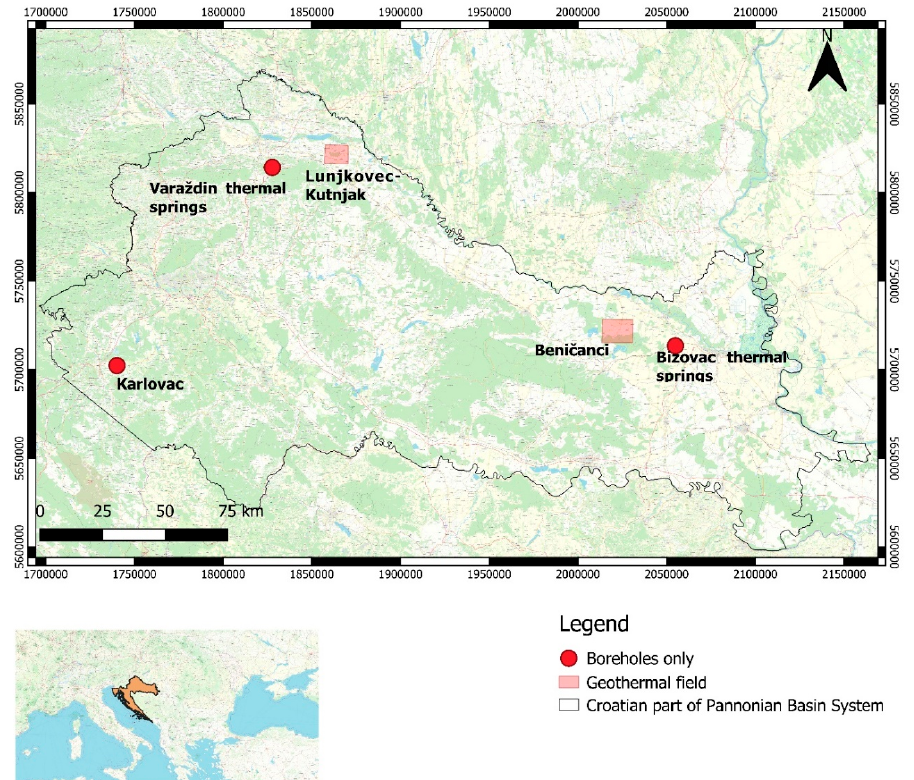
Figure 2. Observed sites. Figure 2. Observed Table 5. Observed sites current and proposed utilisation.